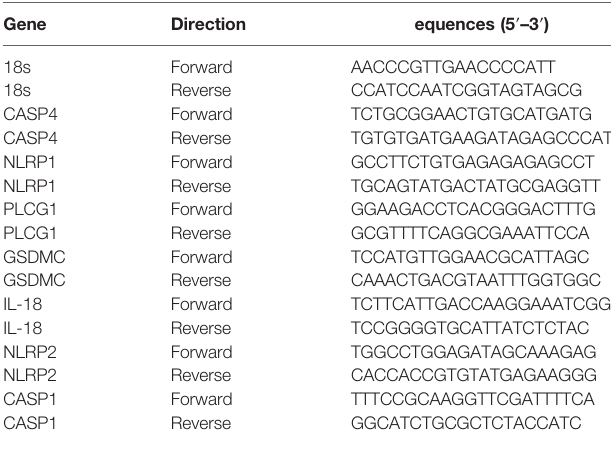
TABLE 1 | Primers used for qRT ‐ PCR